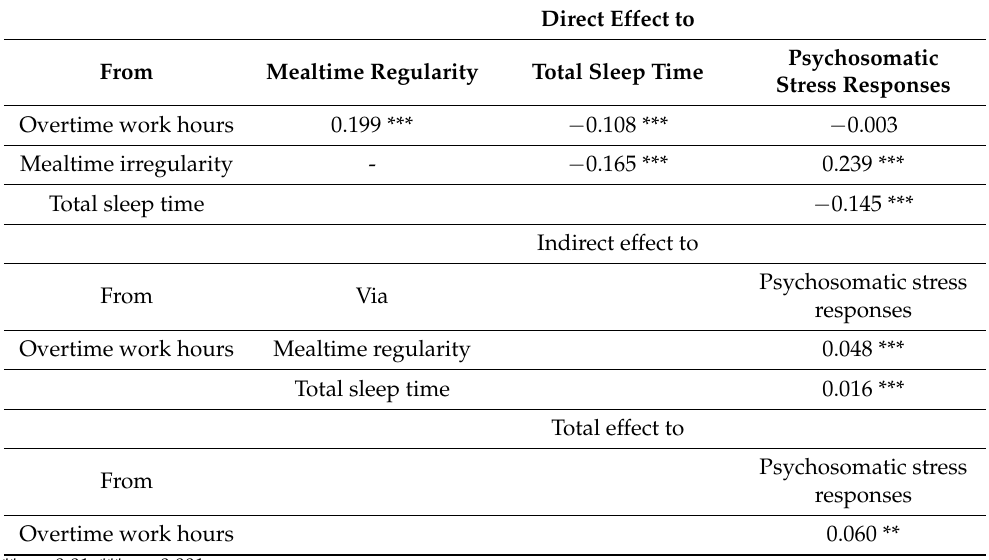
Table 3. Standardized path coefficients between